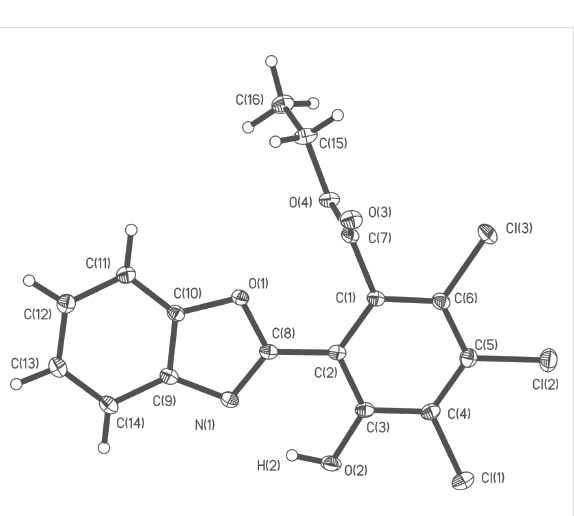
Figure 4: Molecular structure of 2-(2-ethoxycarbonyl-6-hydroxy-3,4,5- trichlorophenyl)benzoxazole 11b . Selected bond lengths